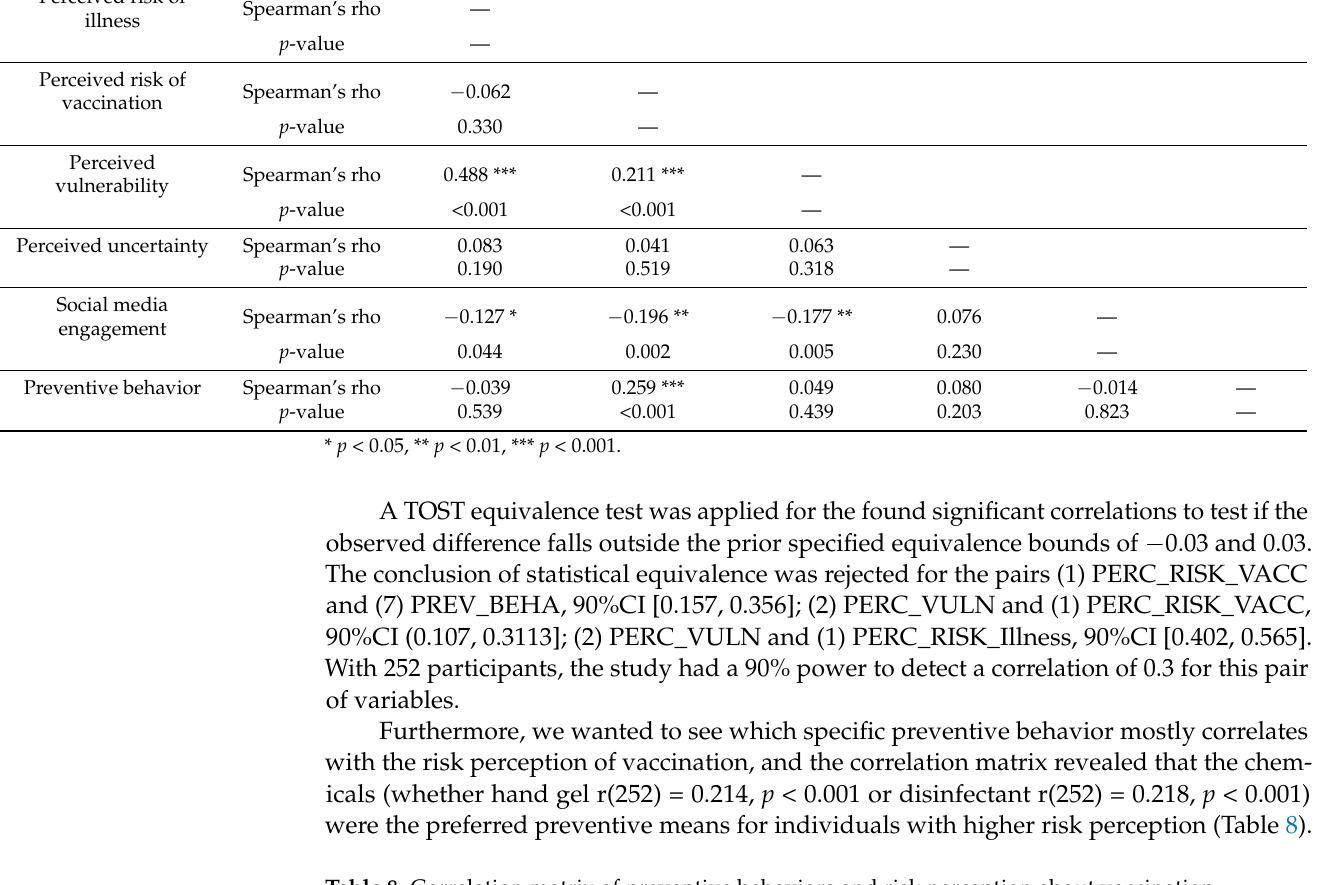
Perceived Perceived Social Media Vulnerability Uncertainty Engagement